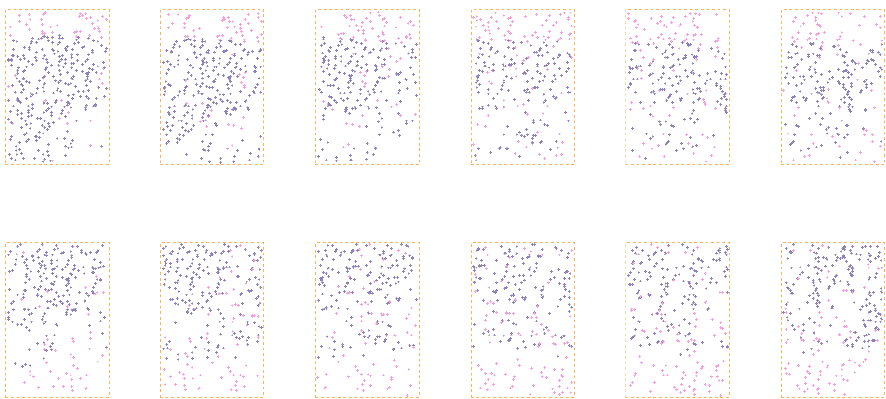
Figure 12. Tie point distribution in images. The dashed rectangles are images. The blue dots are tie points from inter-strips and the pink dots are tie points from the same strip.